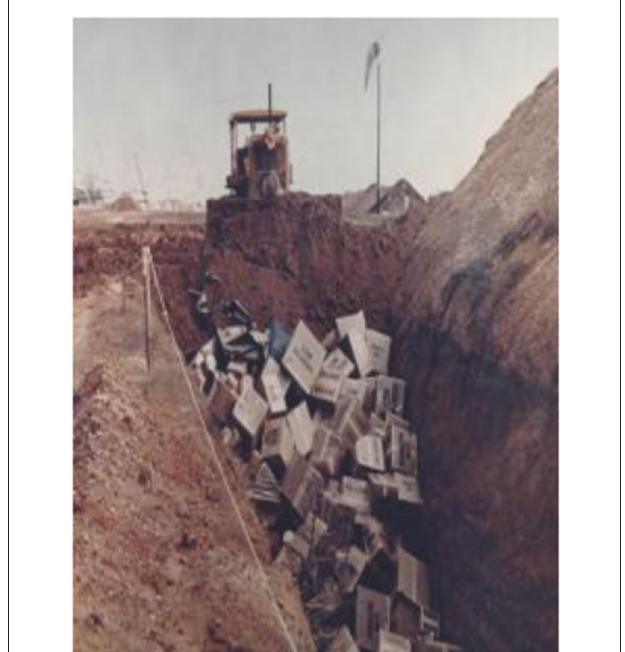
FIGURE 2 | At DOE’s Savannah River Site from the 1950s until 1985, DOE’s waste management permitted 90% of its military solid radioactive wastes to be buried in ordinary cardboard boxes, allowing these boxes to sit in open trenches exposed to the weather for months at a